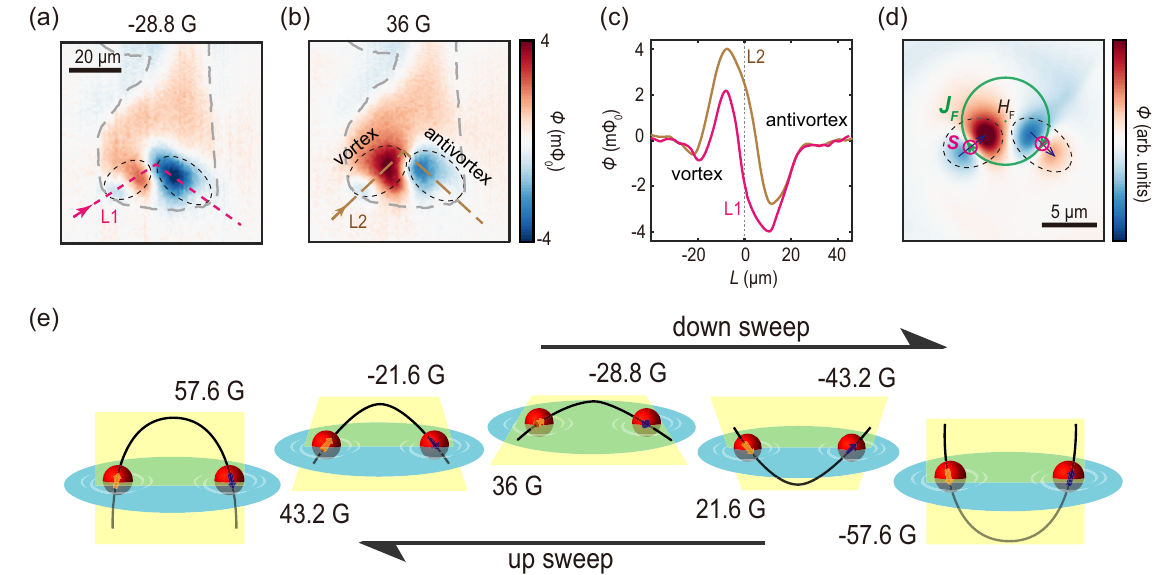
FIG. 4. Vectorial rotation of a QAVand its antivortex. (a),(b) Magnetometry images from Figs. 3(d) and 3(i), respectively, rescaled in color. (c) Line profiles from (a) and (b) along the dashed lines. The origin is set to the center of the field coil. (d) Simulated out-of-plane magnetic field of a QAV-antivortex pair oriented in plane (see text). The local field H F induces a Meissner current J F , which points at different directions at the cores of the vortex and the antivortex. Their impurity moments S also orient oppositely. The torque from the cross product J F × S generates the in-plane spin component (purple arrows). (e) Illustration depicting a pair and its impurity (red spheres) moments (orange and purple arrows) rotating about their central axis when a local field was applied. The blue circular plate represents the sample in plane; the black line represents the flux line which goes through the impurity moments; the yellow plane is an auxiliary plane the moments and the flux line are confined to. The fields match the corresponding fields in Figs. 3(a) – 3(j). Such polar rotations of the flux line of QAV differentiated it from horizontal motion of an Abrikosov vortex by a local probe and suggested a new mechanism enabling efficient manipulation of